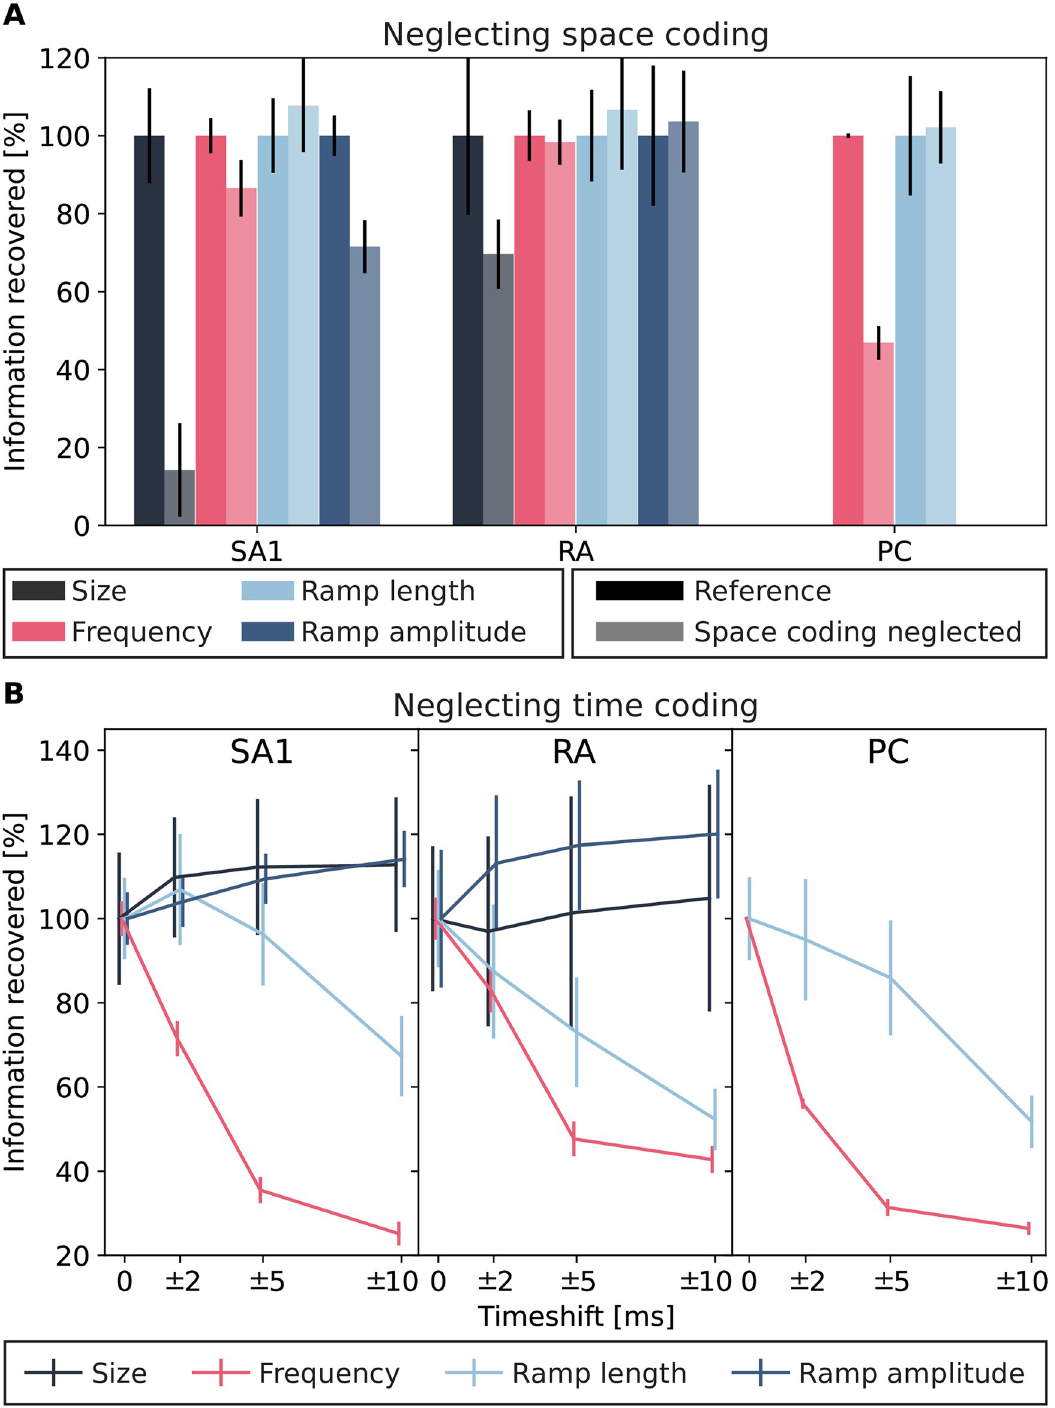
Fig 6. Information recovered after destroying spatial or temporal coding. (A) Information recovered for each afferent class after neglecting afferents’ spatial organization normalized with respect to the maximum information content in the original data at the saturation level (see Fig 3C). (B) Information recovered for each afferent class after destroying precise spike timing at different timescales. Again, information is normalized with respect to the maximum information content in the original data at the saturation level. Error bars represent standard deviation across different NMF instantiations. Note that for both stimulus size and ramp amplitude, information carried by PC class was null (see Fig 3C) and such class was excluded from these analyses.